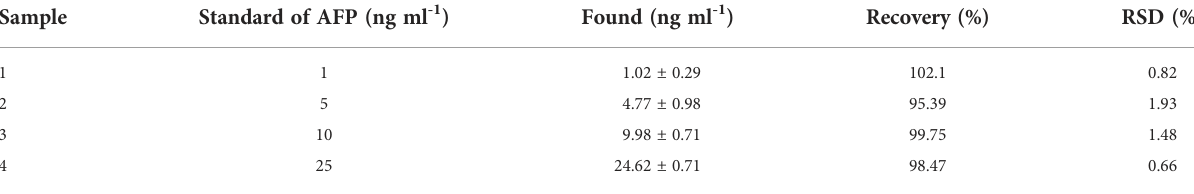
TABLE 2 Recovery study for the determination of AFP in human serum by the present immunosensor.